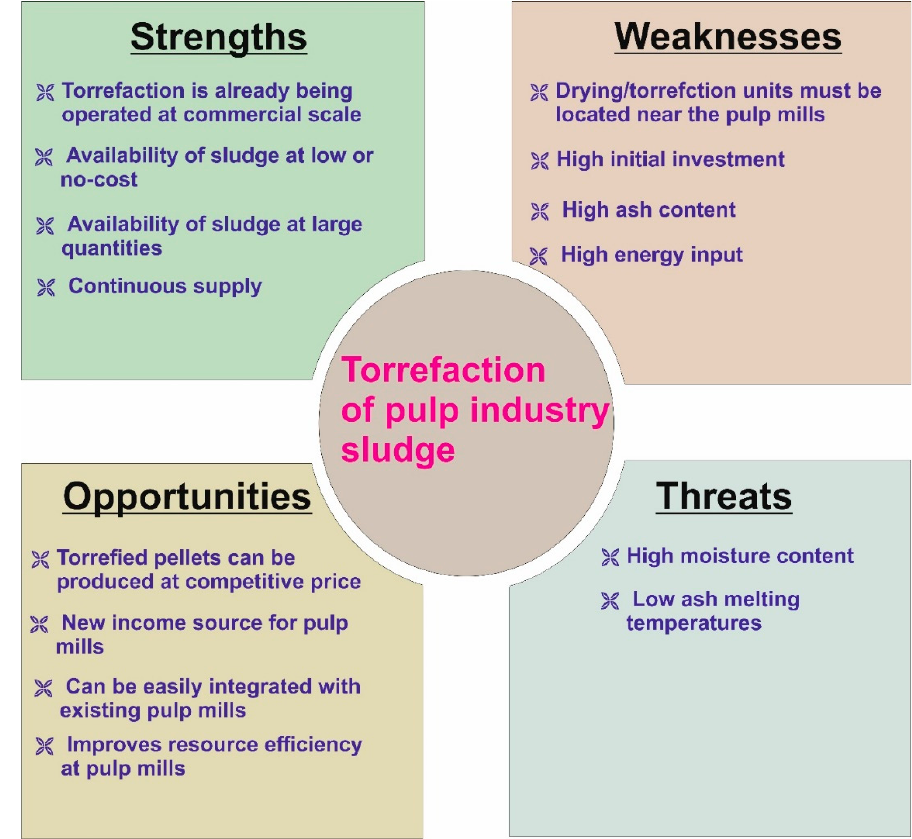
Figure 5. SWOT analysis of the torrefaction of pulp industry sludge.